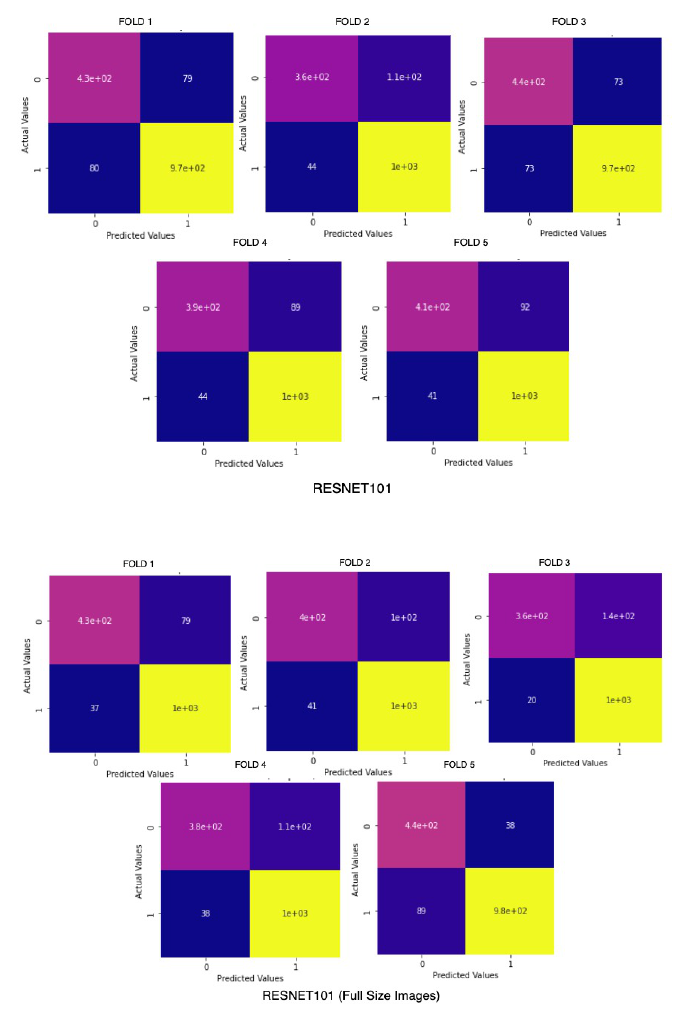
Figure 3. ResNet101 on BreaKHis on cropped ( above ) and original sized images ( below